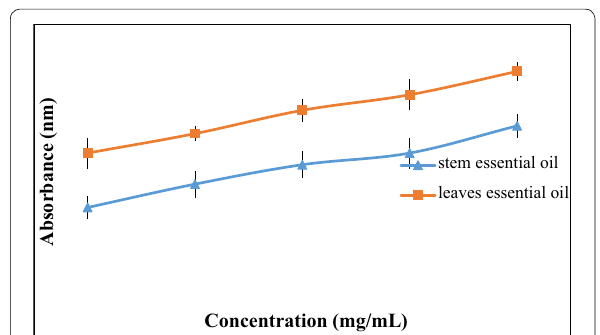
Fig. 3 Reducing potential of D. mucronata Royle essential oils